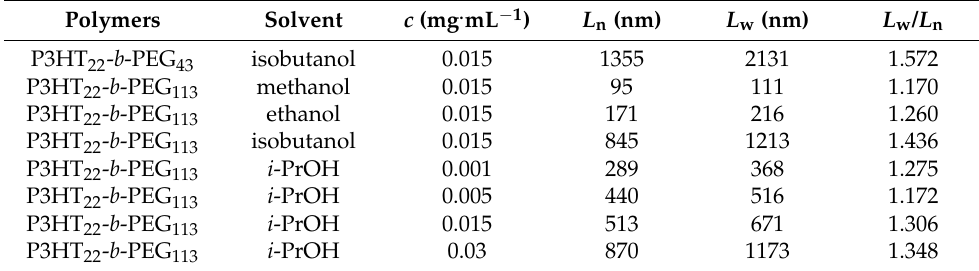
Table 2. Summary data of the